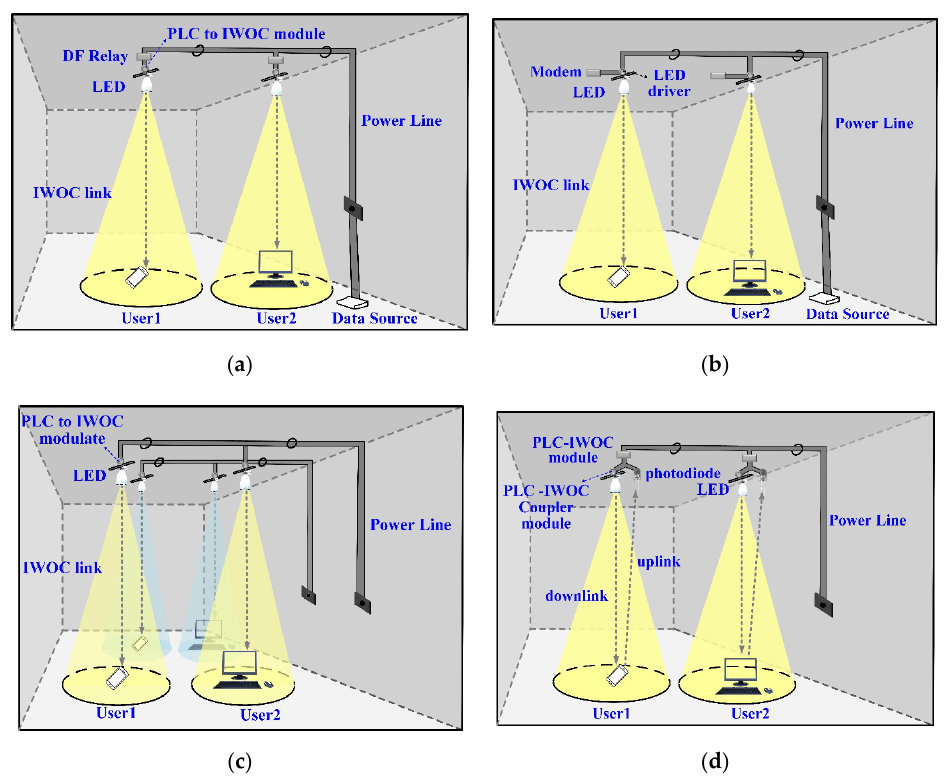
Figure 15. The different schemes of IWOC-PLC systems: ( a ) DF relay hybrid IWOC-PLC scheme [15], ( b ) hybrid IWOC-PLC scheme [15,16,19]; ( c ) multichannel hybrid IWOC-PLC system [15]; ( d ) full duplex DF IWOC-PLC scheme [17].